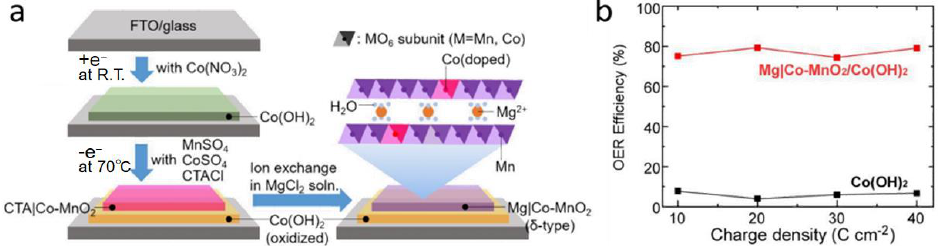
Figure 4. ( a ) Mechanism workflow chart of Mg|Co-MnO 2 formation. ( b ) The relationship between the charge density and OER efficiency of Mg|Co-MnO 2 /Co(OH) 2 [47]. Adapted with permission Ref. [47], Copyright 2020, American Chemical Society.